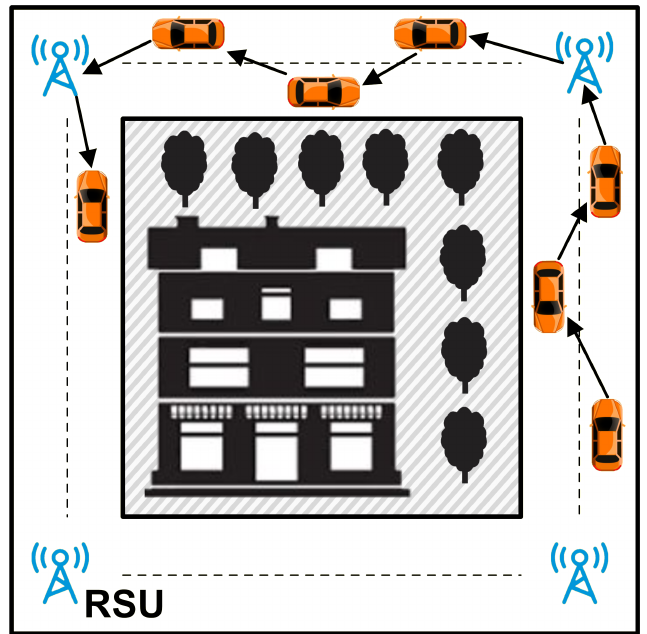
Figure 23. Scenario 2: data communications in multiple road